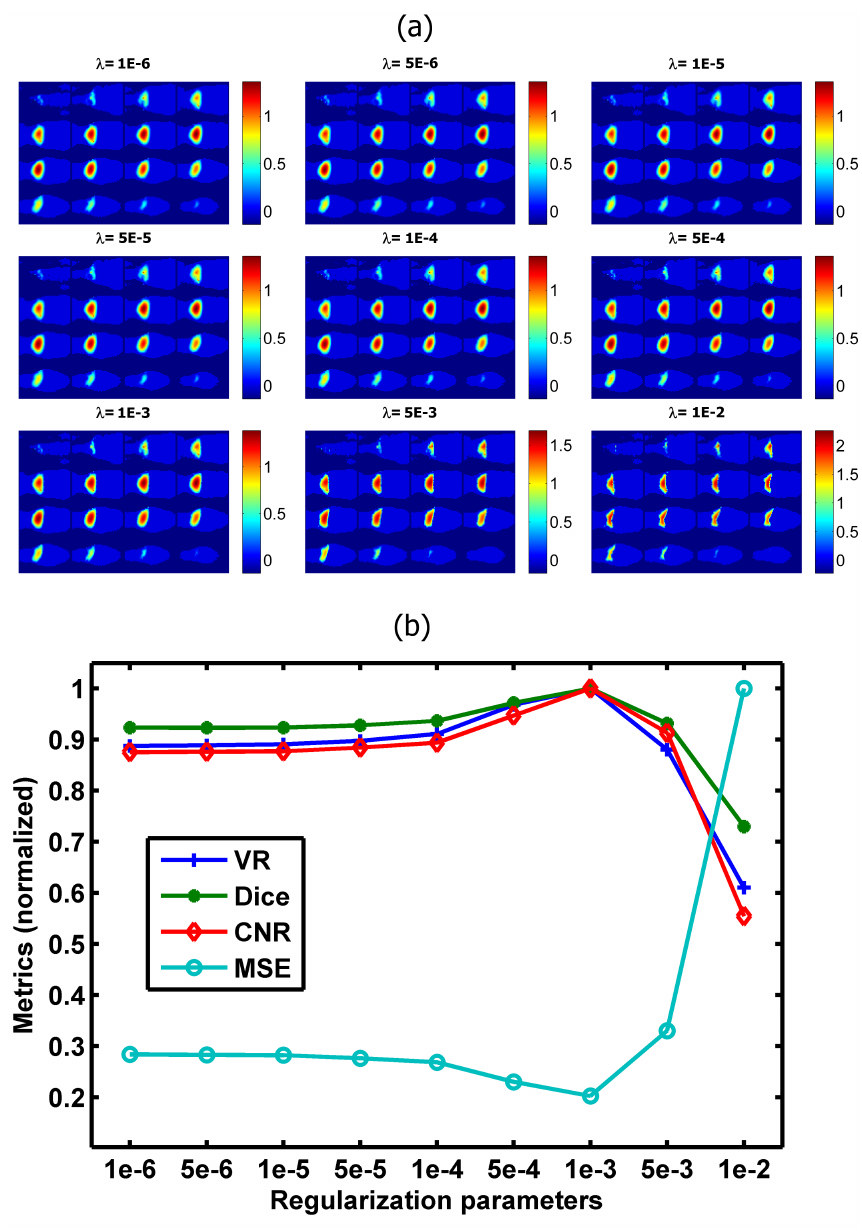
Figure 4. Selection of regularization parameters for Log on a large target, by visual and by metrics, respectively: ( a ) reconstructed fluorescence molecular tomography (FMT) images with Log regularization using different regularization parameters; ( b ) normalized metrics for the images in